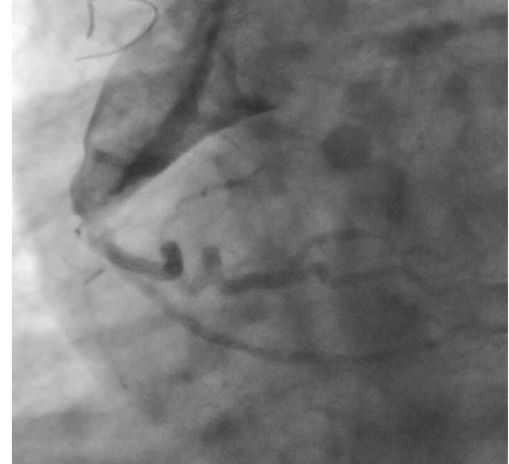
Figure 2: Coronary angiography of the right coronary sinus of Valsalva. The appearance was suggestive of aneurysmal dilatation of the right coronary artery ostium.